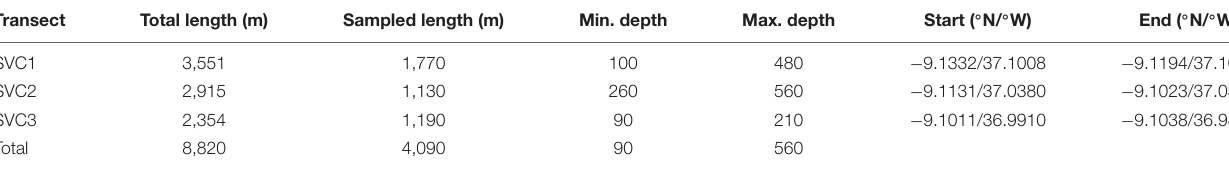
TABLE 1 | Summary of the three remotely operated vehicle (ROV) recorded transects in São Vicente Canyon.